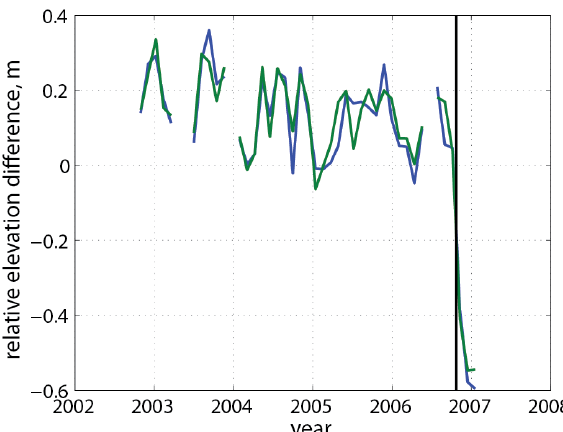
Fig. 3. Envisat elevation time series computed only from data ac- quired before the drainage, at two adjacent locations over Lake Cook E2 . Envisat radar altimetry provides the best estimate of the date of the initiation of the drainage (vertical black line,